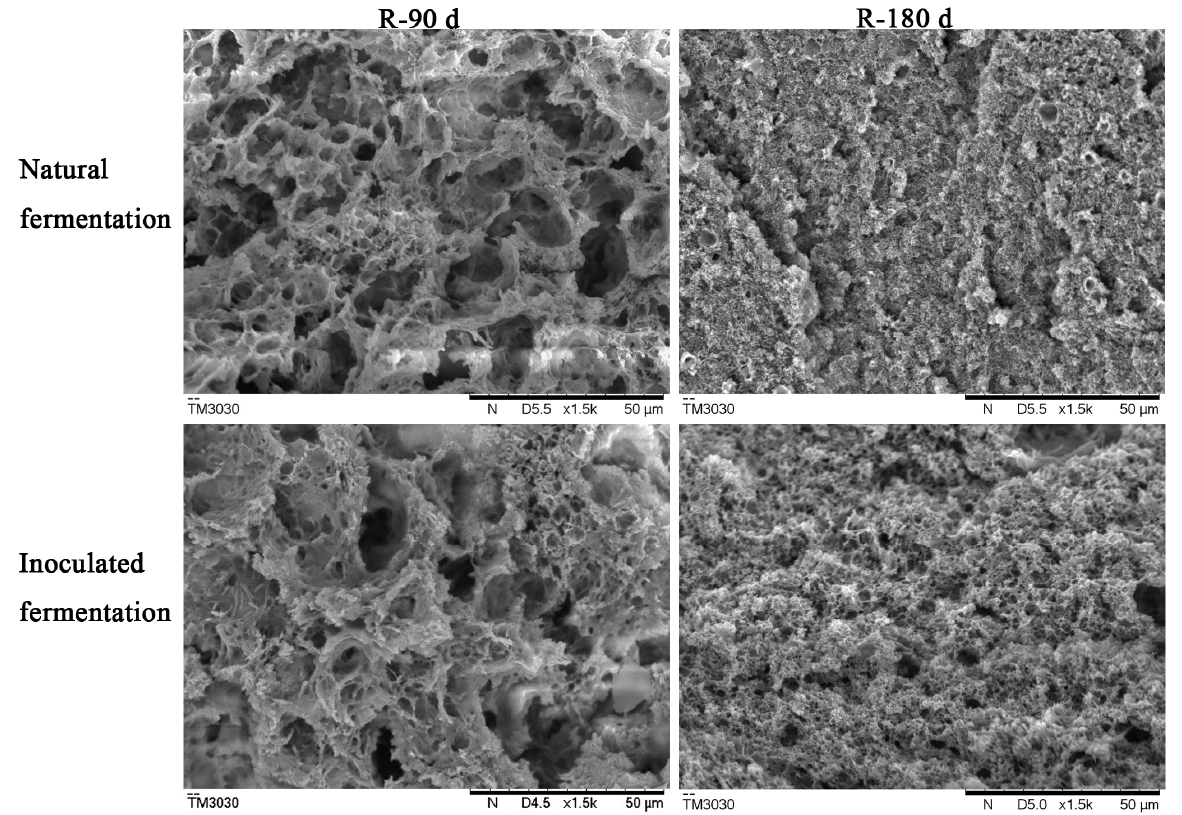
Figure 3. SEM micrographs of natural and inoculated fermented sufu after 90 and 180 d of fermen-